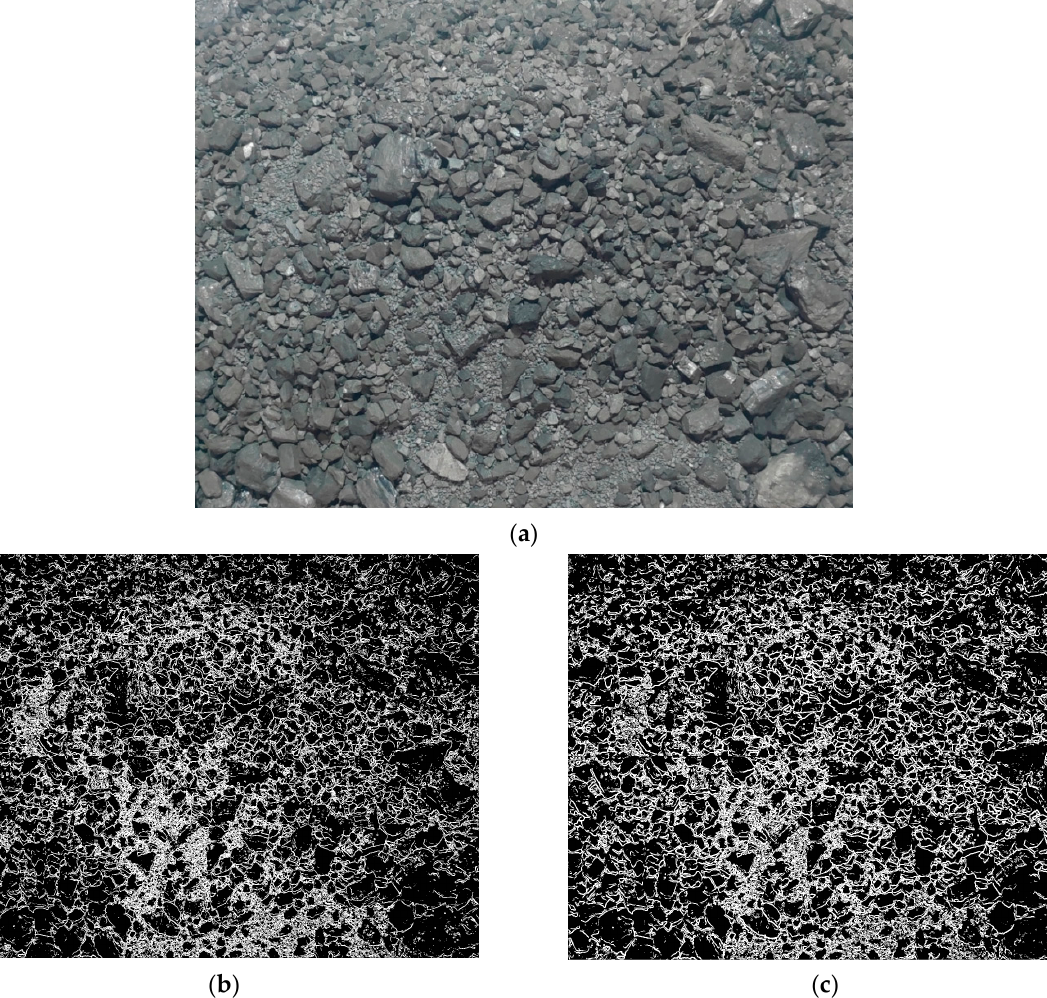
Figure 5. Edge image of coal with and without wavelet denoising. ( a ) Original coal image; ( b ) edge image without wavelet denoising; ( c ) edge image with wavelet denoising.